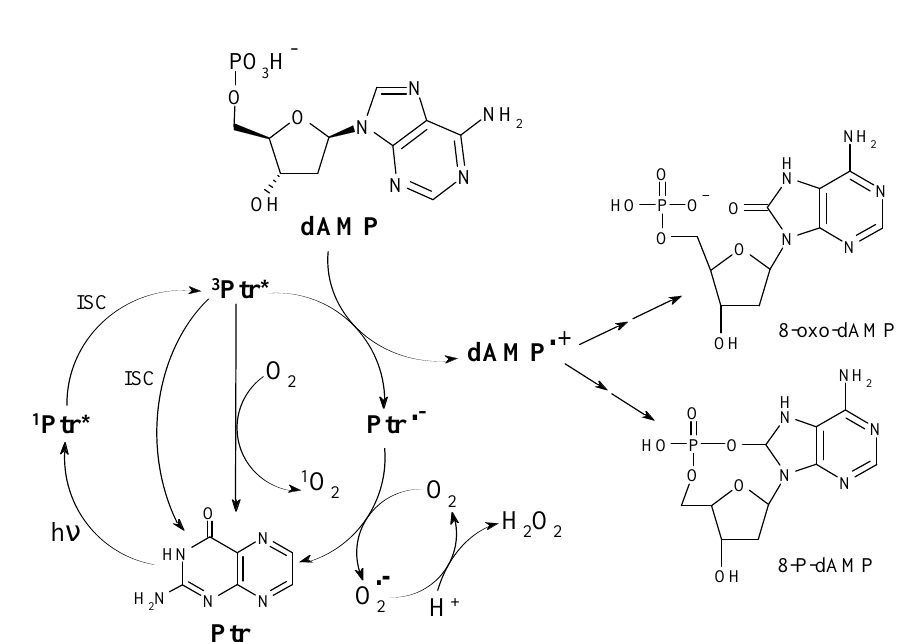
Figure 3. Mechanism of the oxidation of dAMP photosensitized by pterin (Ptr)